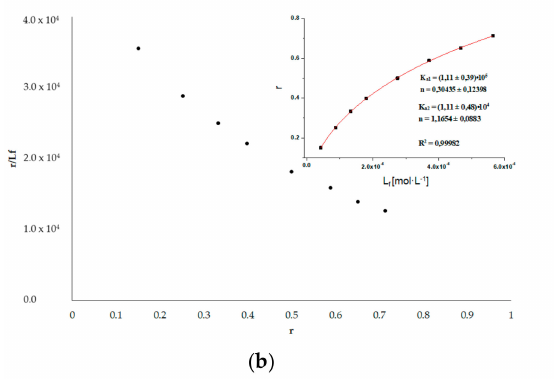
Figure 7. Scatchard curve for ( a ) dPro–HSA FR and ( b ) dPro–HSA INC systems. The inserts show the binding isotherms; λ ex 350 nm.